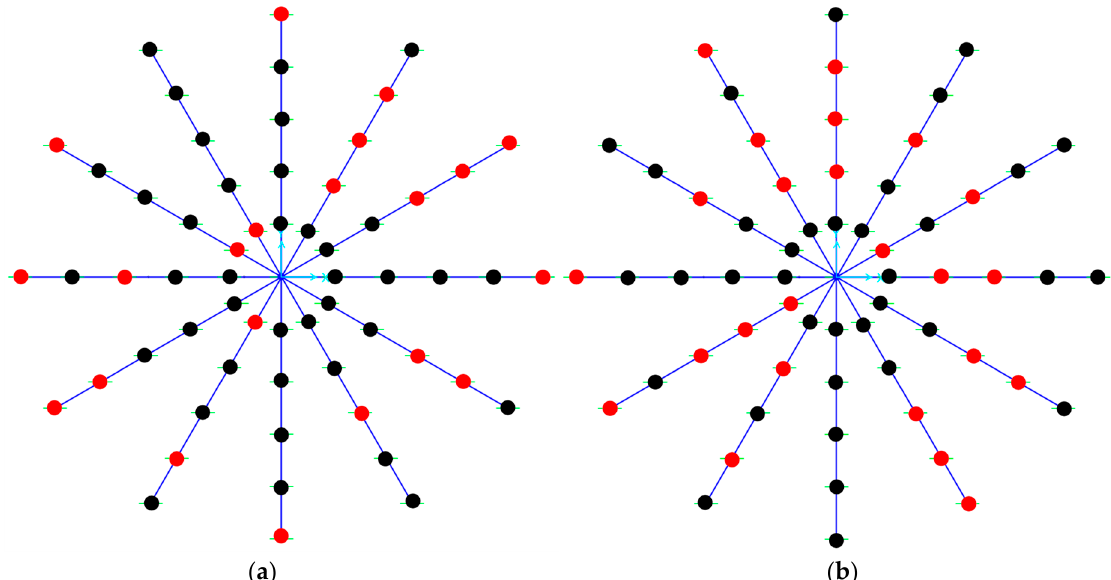
Figure 7. Optimal placement for: ( a ) SFPB3 and ( b ) TFPB3 isolators, in which black dots denote active bearings, while “zero-isolators” are represented with red dots.